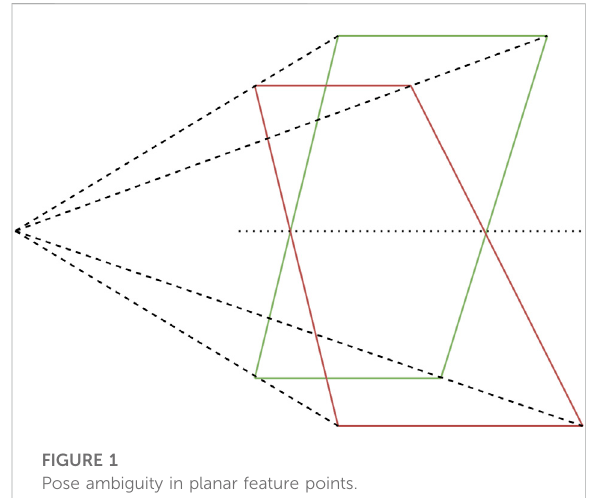
FIGURE 1 Pose ambiguity in planar feature